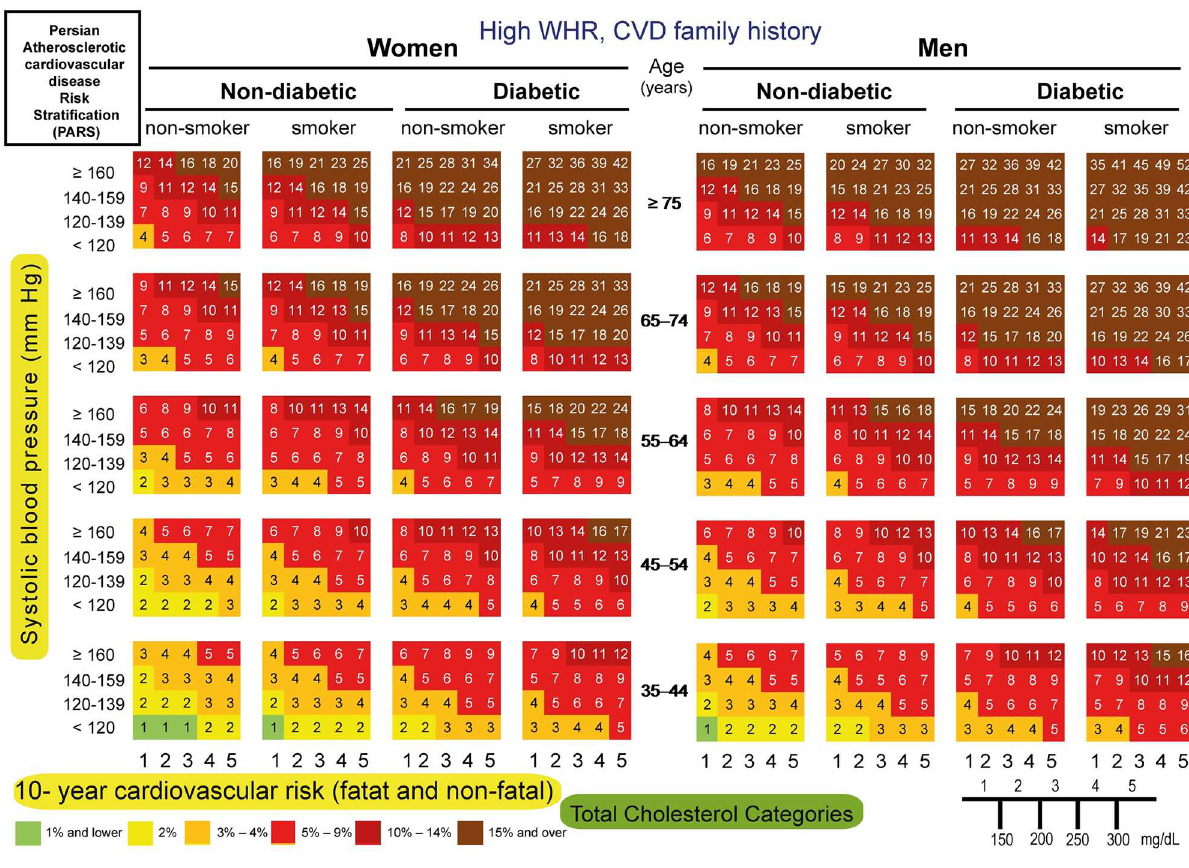
Fig 6. PARS charts for prediction of 10-year risk of fatal and non-fatal cardiovasculardisease in ICS population with higher WHR and CVD family history, 2001–2011.